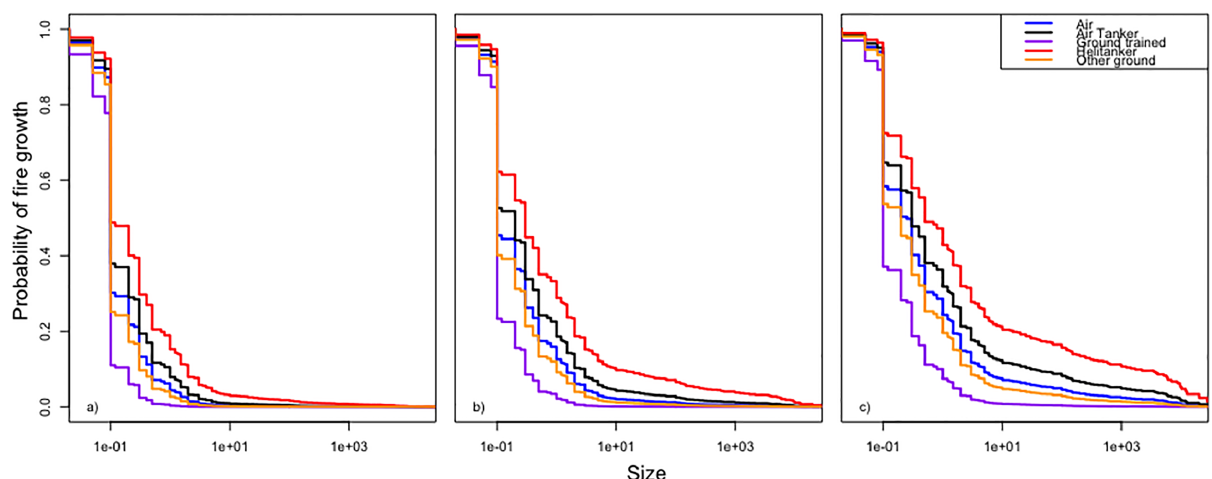
Fig 7. Cox proportional hazard model fitted survival curves for all levels of IA method under fuel type C2 and contrasting levels of FWI. Levels of Method are represented by Air (blue line), Air tanker (black line), Ground trained (purple line), Helitanker (red line) and Other ground crews (orange line). FWI values are respectively the 5th (a) FWI = 4), 50th (b) FWI = 18) and 95th (c) FWI = 31)